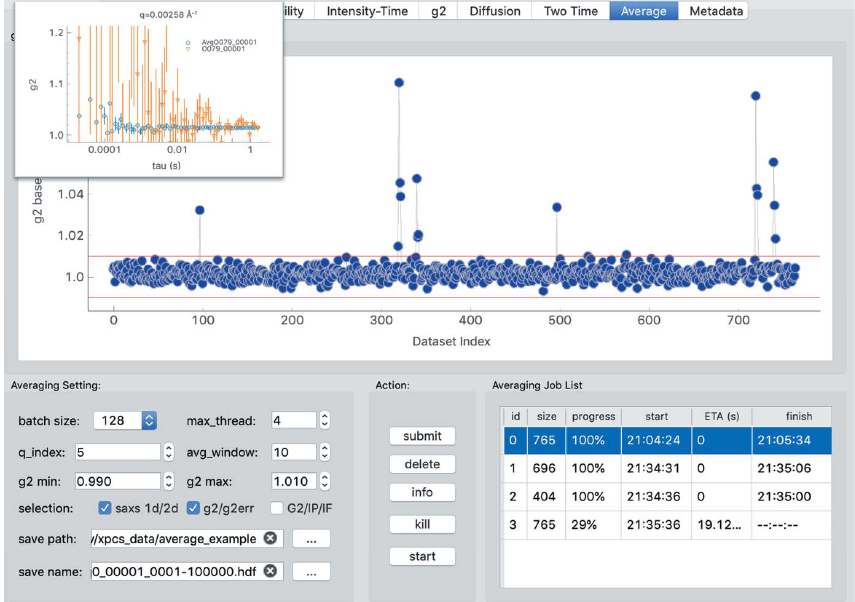
Figure 6 The averaging toolbox. Users set up a cutoff to remove outliers. The averaging jobs can be managed in the Action panel. The plot inset (top left) shows the g 2 curves for a single dataset (orange) and the averaged result of 765 datasets (blue), showing a significant improvement in signal-to-noise ratio obtained by suitable